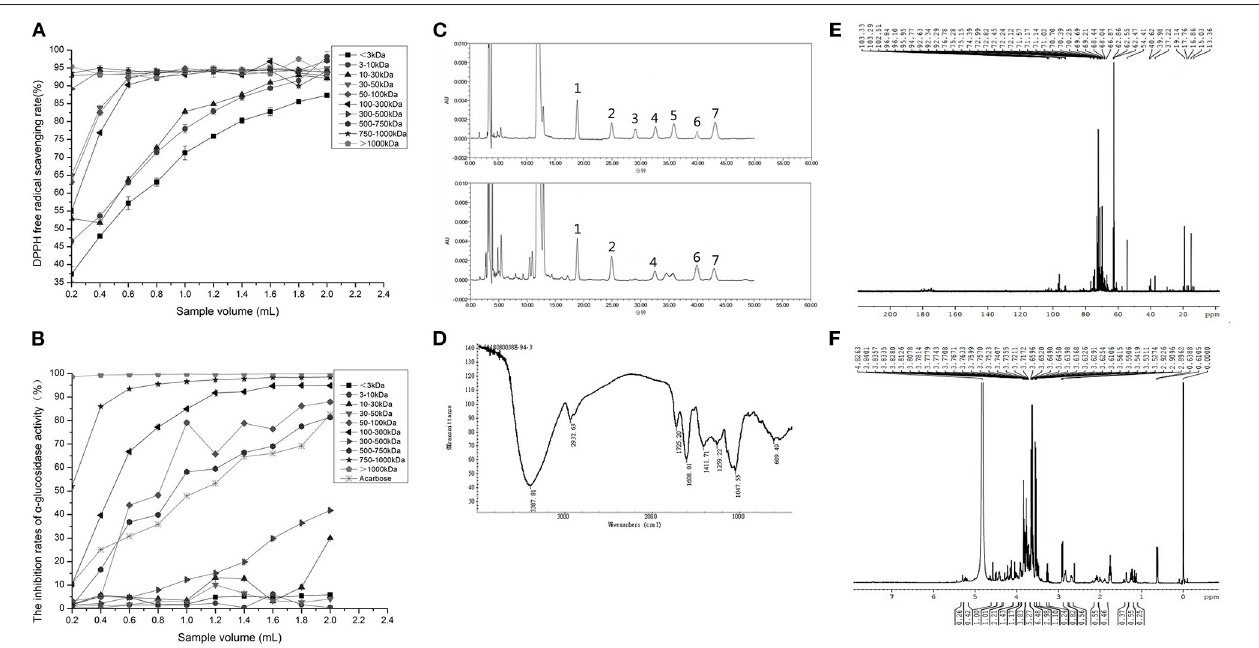
FIGURE 2 | Functional activities and chemical structures of Niuxin plum wine polysaccharides (NPWPs). DPPH radical-scavenging rates of NPWPs with different molecular weight (A) , anti-hyperglycemic activities of acarbose and NPWPs with different molecular weights (B) , HPLC chromatogram of mixed monosaccharide standards and monosaccharide compositions of NPWPs (C) , (1: mannose, 2: rhamnose, 3: glucuronic acid, 4: galacturonic acid, 5: glucose, 6: galactose, and 7: arabinose), infrared spectrum of NPWP with molecular weight > 1,000 kDa (D) , 13 C NMR spectrum of NPWP with molecular weight > 1,000 kDa (E) , and 1 H NMR spectrum of NPWP with molecular weight > 1,000 kDa (F)